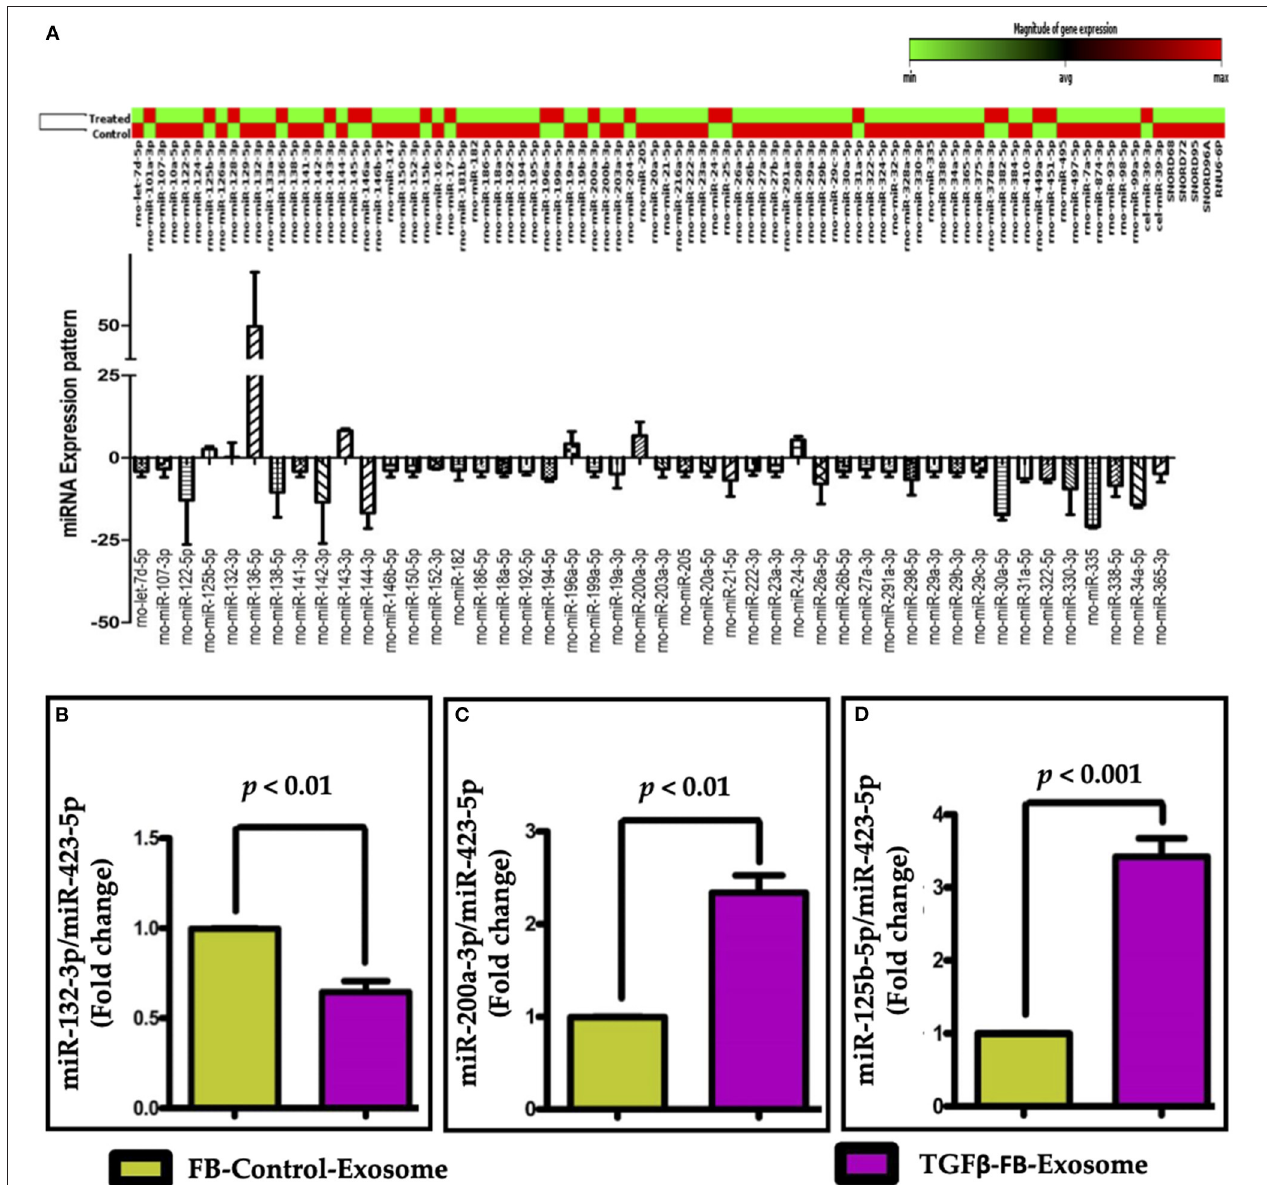
FIGURE 6 | Fibrosis miRNA array along with expression profile and validation of selected miRNAs in exosomes. (A) Fibrosis-miRNA array was performed in neonatal rat fibroblast-derived exosomes after TGF β activation. Heat map of fibrotic miRNA array data suggest an altered expression of miRNAs in TGF β -activated FB-derived exosomes as compared to control exosome. The change in expression of selected miRNAs was further confirmed by qPCR by comparing the expression of miRNAs (B) miR-132-3p, (C) miR-200a-3p, and (D) miR-125b-5p, in activated-FB-derived exosomes. P < 0.05 vs. control exosome and PBS